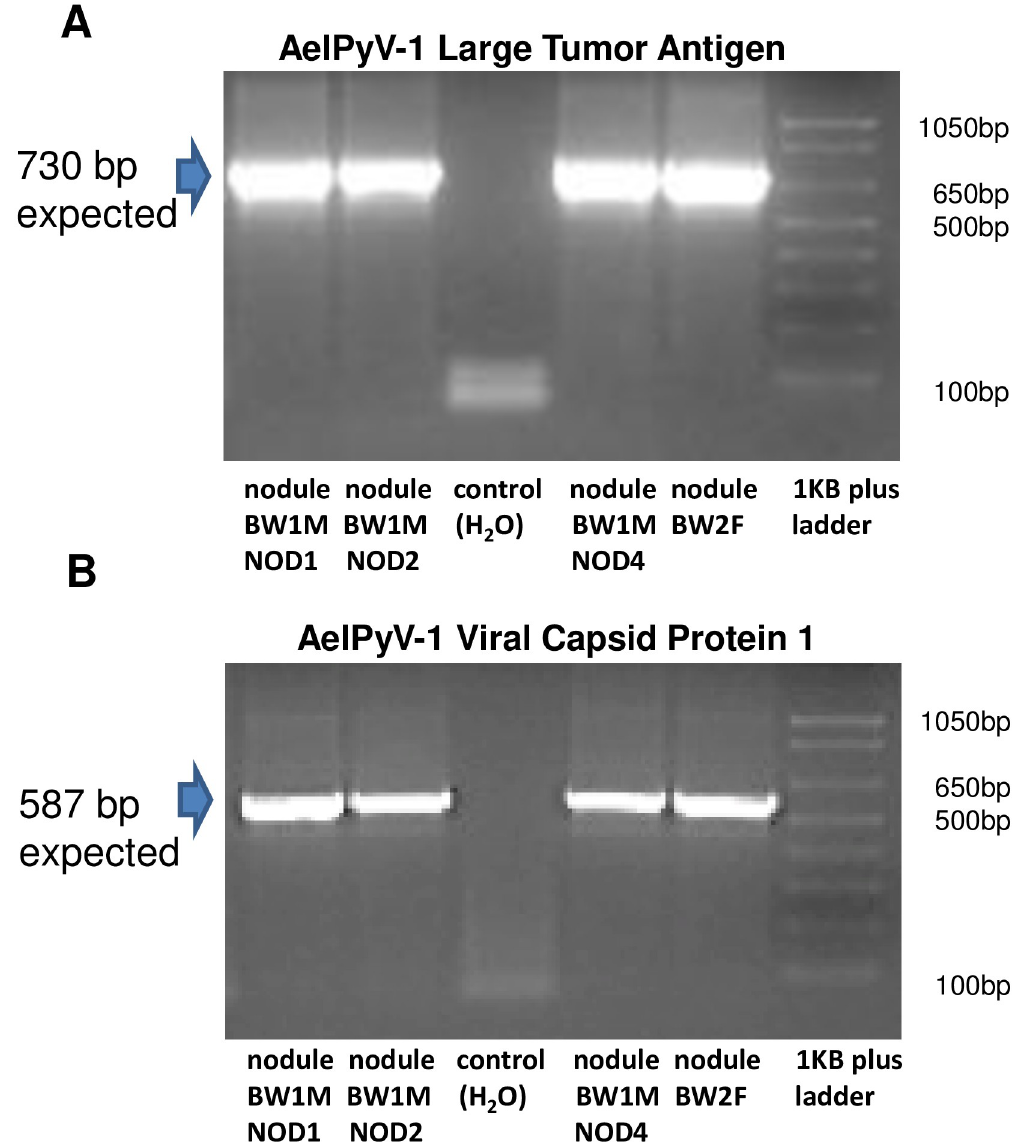
Fig 2. PCR analysis of biological specimens. PCR analysis of elephant trunk nodules in Botswana and South Africa to detect: A) AelPyV-1 large tumor antigen (expected size 730 bp) and B) viral capsid protein 1 (expected size: 587 bp).